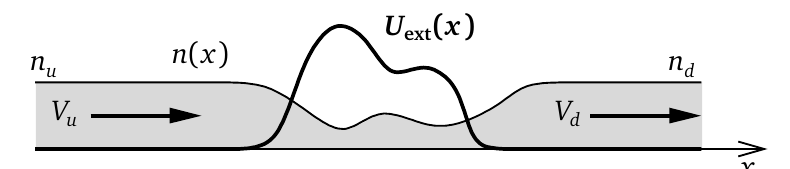
Figure 11: Sketch of the situation considered in appendix C. The far upstream and far down- stream asymptotic flows are both subsonic. The obstacle is represented by a localized external ( x ) potential U ext